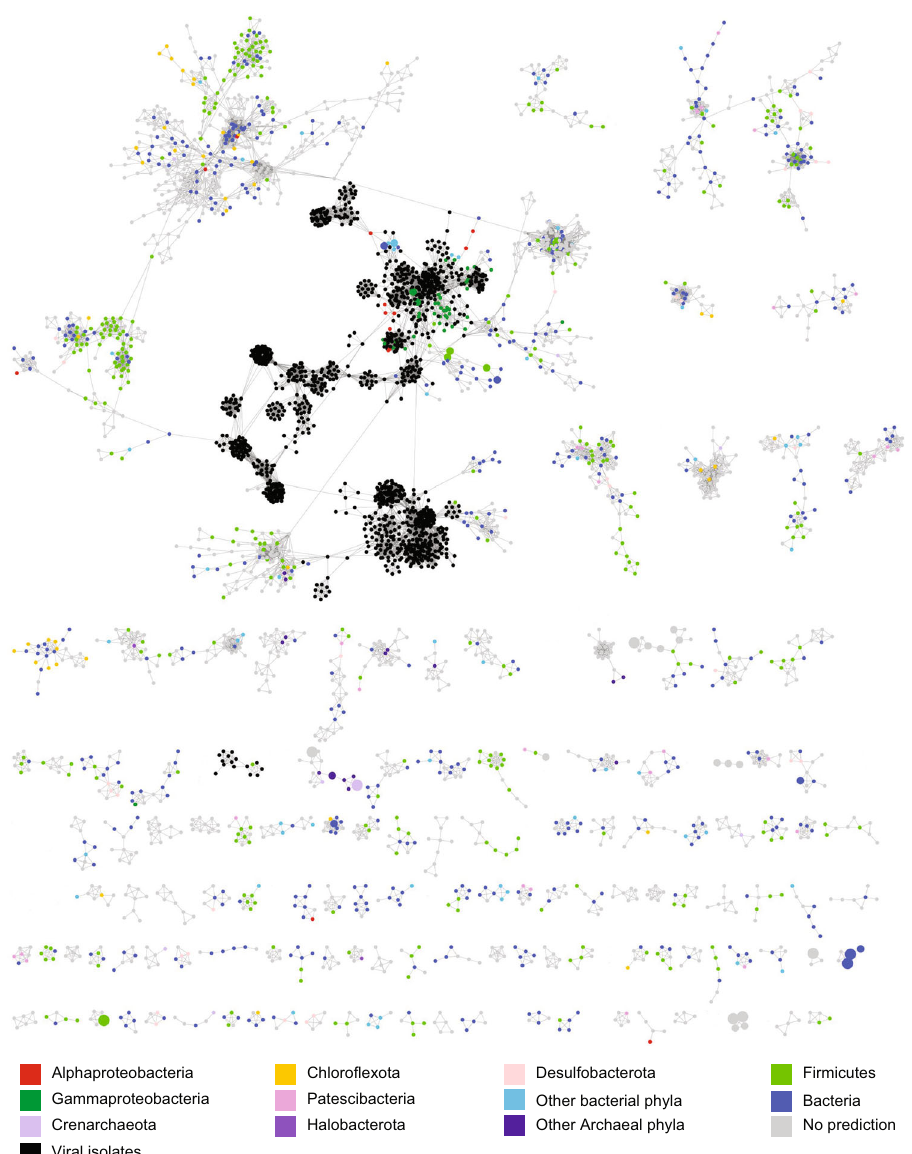
Fig. 5 Network displaying Äspö HRL contigs and isolated viruses highlighting potential hosts. A selected portion of the network analysis of the contigs from the MM-171.3, MM-415.2, and TM-448.2 groundwaters along with sequences from bacterial and archaeal viral isolates in the NCBI RefSeq database. Colored nodes represent predicted microbial hosts based upon k-mer analysis of the Äspö HRL viral contigs (full data in Supplementary Data 1). Node sizes are as described in Fig. 1. The complete and unedited Cytoscape fi gure is available in Figshare 35